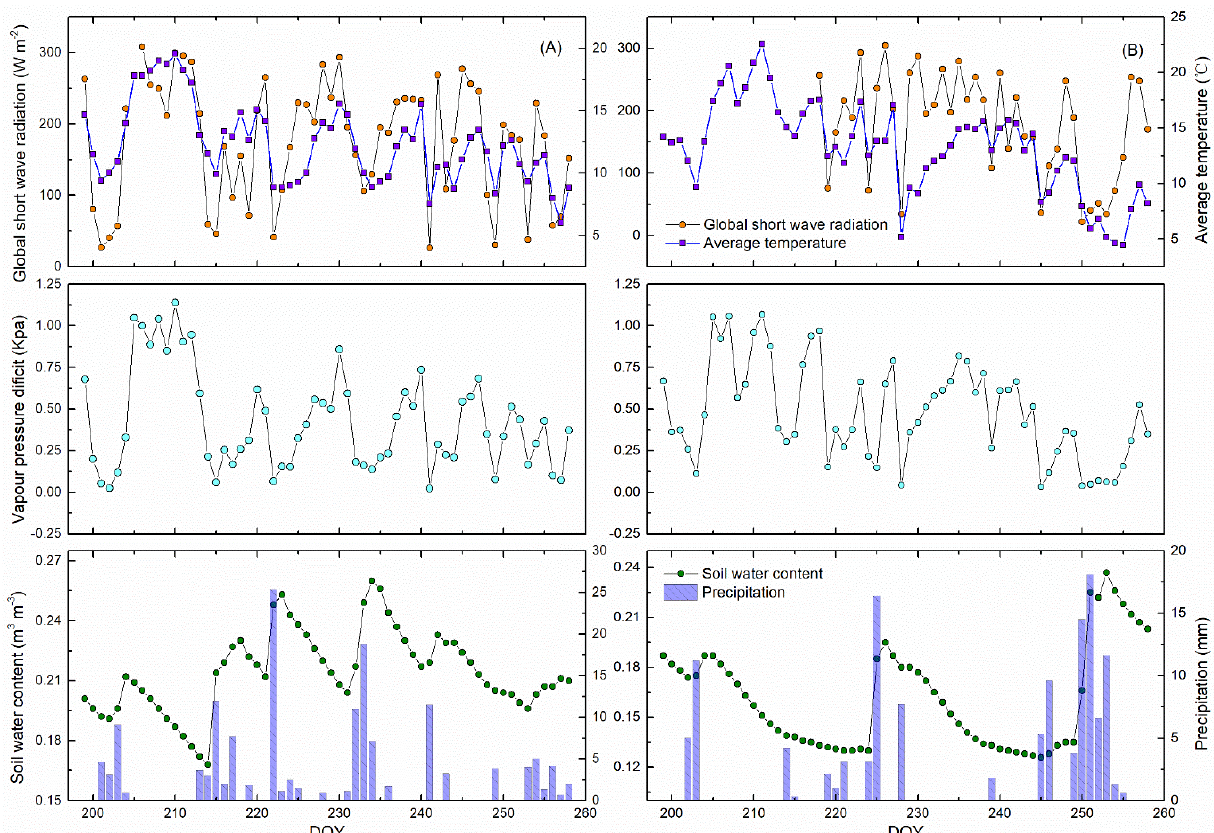
Figure 2. The environmental conditions during the growing seasons in the treatment group (figures in column A ) and control group (figures in column B